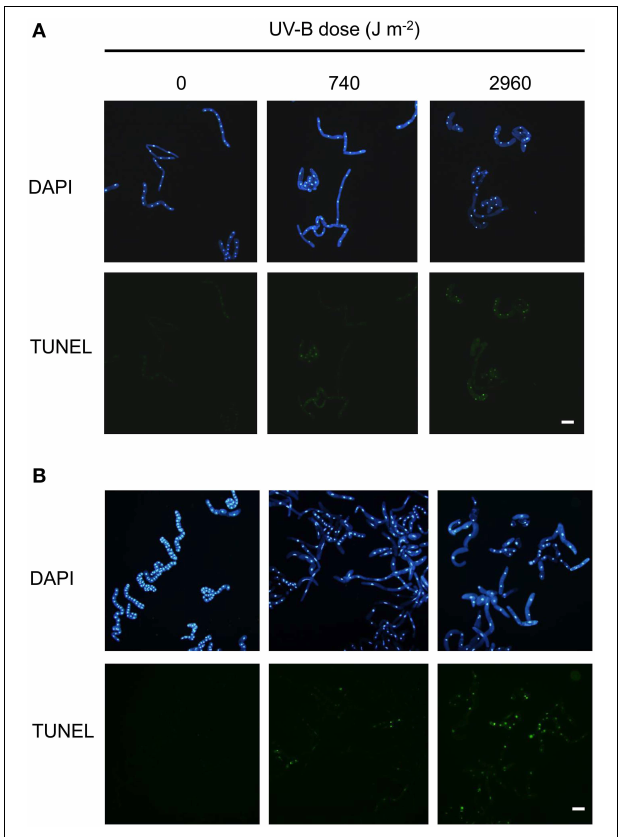
FIGURE 6 | Fragmented DNA in cells irradiated with low- and high-dose UV-B. BY-2 cells were irradiated with UV-B (0, 740, or 2960 J m − 2 ) and cultured for (A) 1 day or (B) 3 days. DNA fragmentation was analyzed by TUNEL assay. Fluorescein signals (TUNEL) and DAPI staining are shown. Bars = 100 µ m.